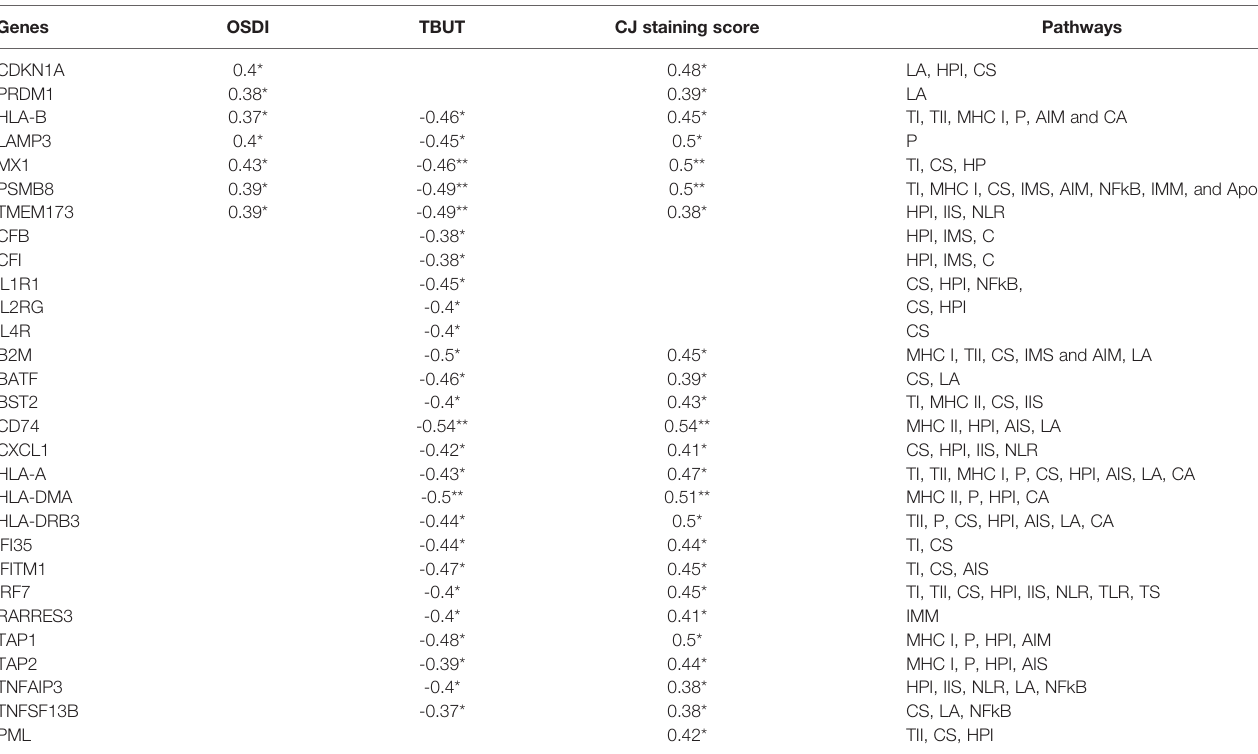
TABLE 4 | Spearman correlations with clinical symptoms (OSDI), Tear-break-up time (TBUT), and conjunctival (CJ) staining score were calculated using GraphPad Prism software using clinical data from all subjects (19 healthy controls and 7 SS KCS subjects). Out of 54 DEGs, only 29 of the upregulated DEGs showed a correlation. Genes OSDI TBUT CJ staining score